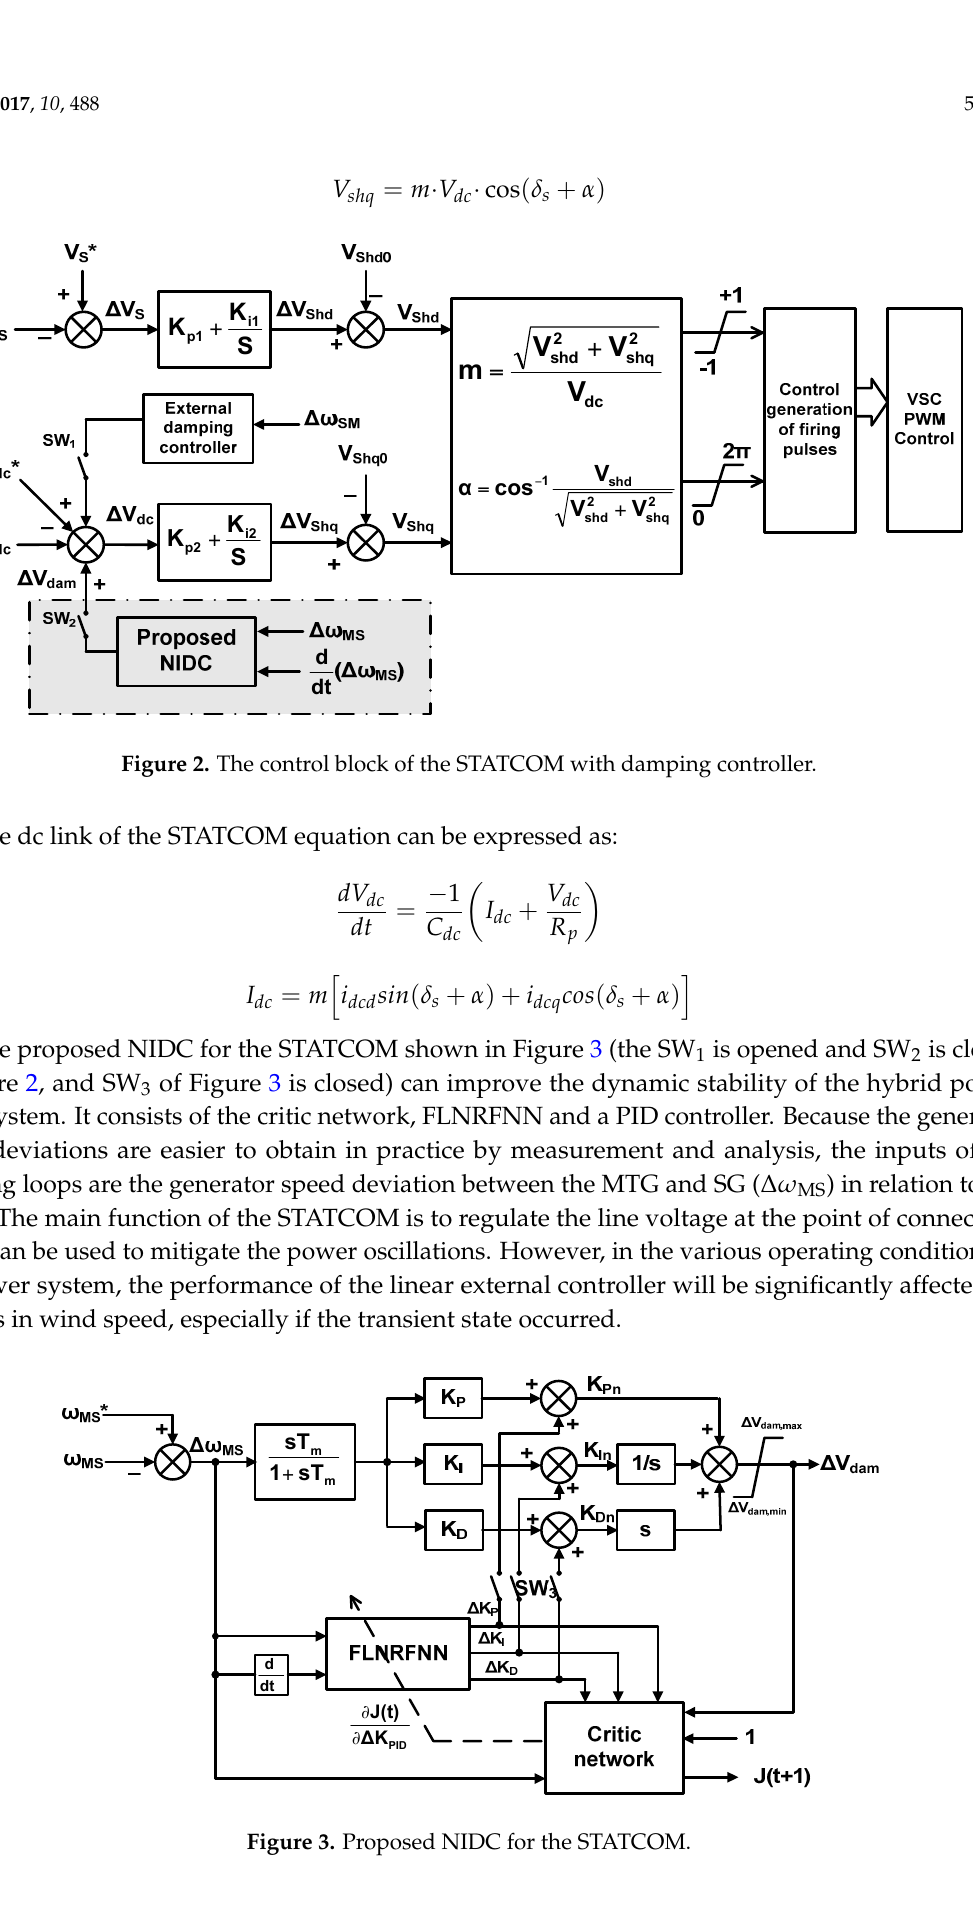
Figure 3. Proposed NIDC for the STATCOM.